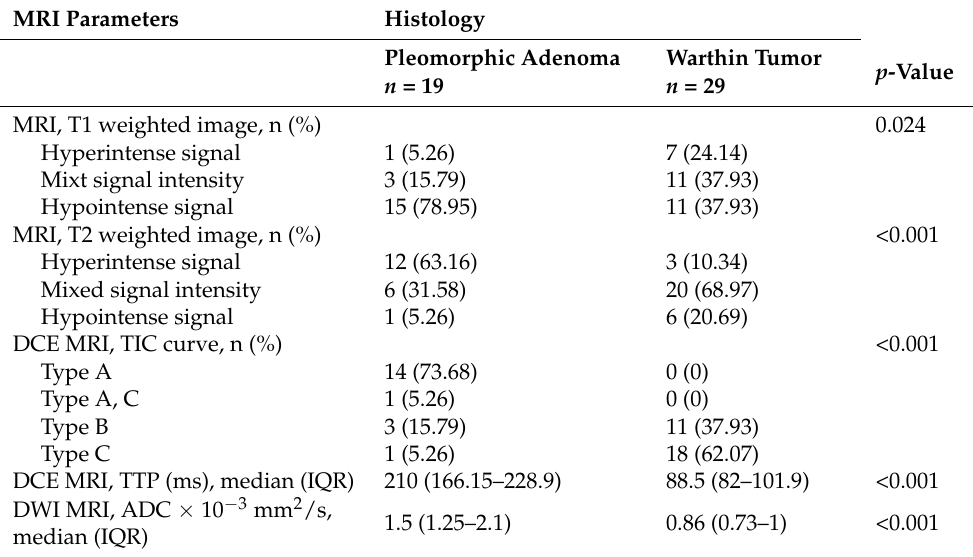
Table 4. Multiparametric MRI parameters—comparison between pleomorphic adenomas and Warthin